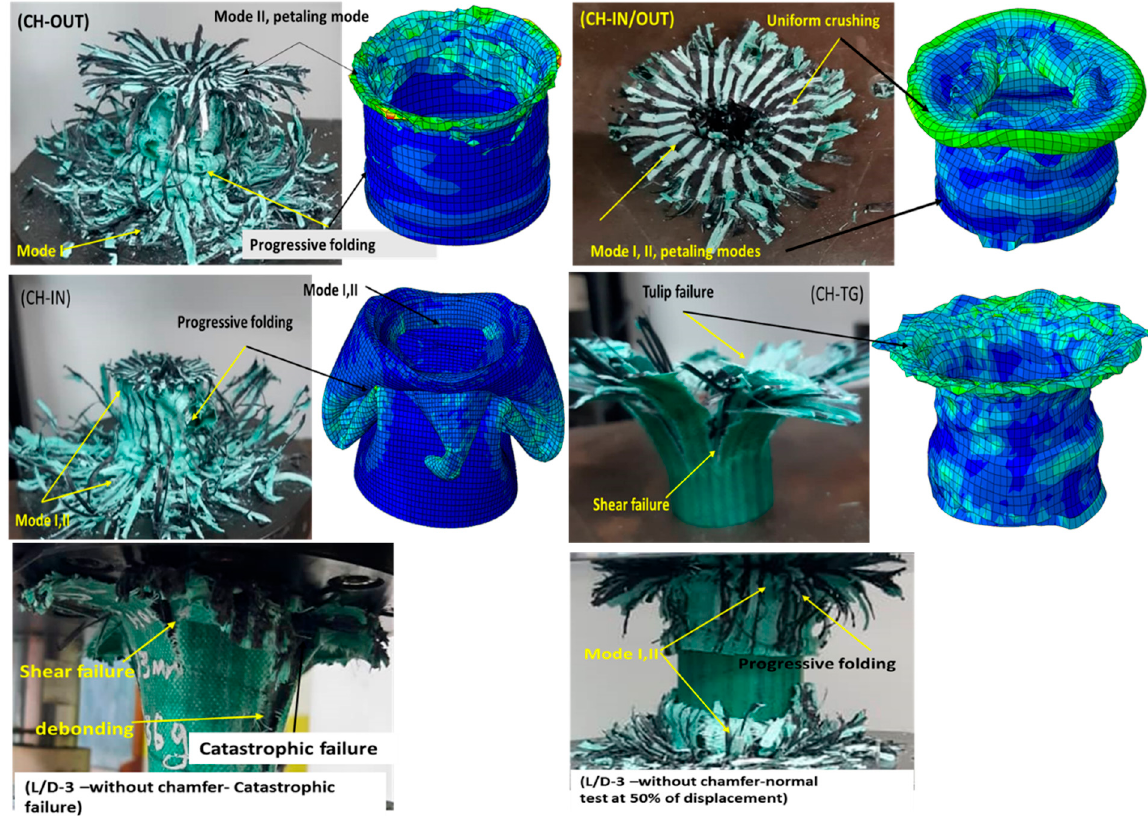
Figure 11. Failure mechanisms of composite tubes with a different chamfering trigger mecha- nisms.